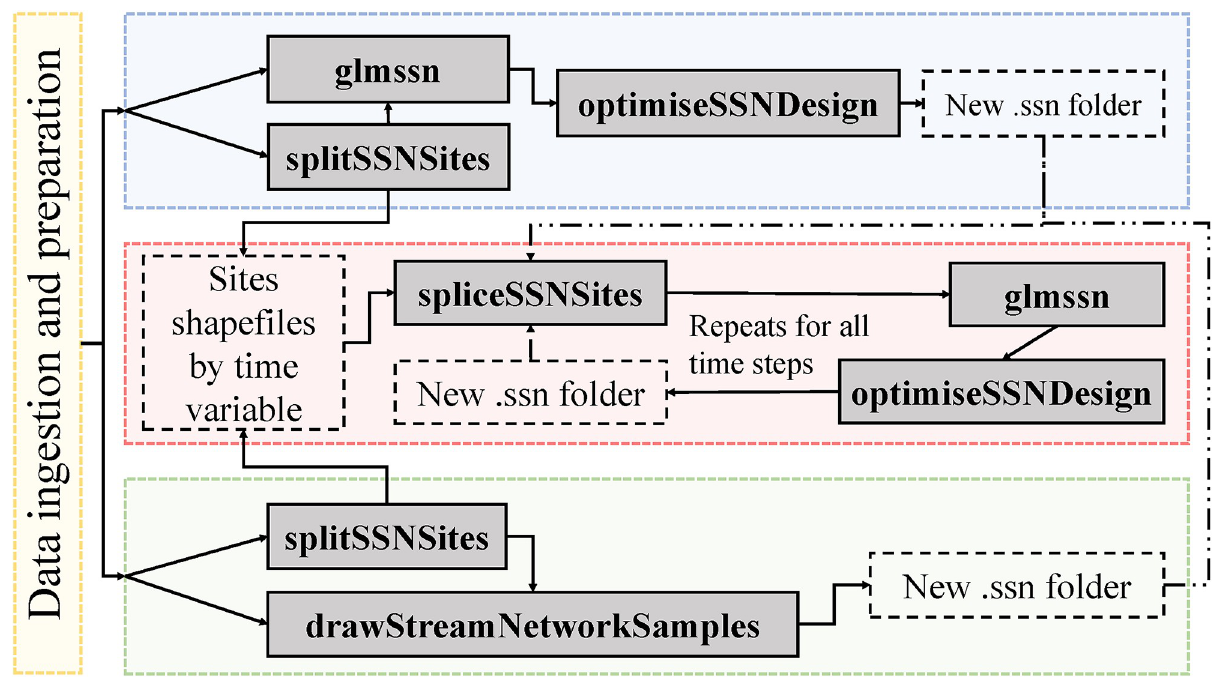
Fig 2. A flow chart of the function calls used to construct optimal (blue), adaptive (red), and probability-based (green) designs for stream networks. The yellow box is discussed in more detail in Fig 1. Grey boxes with solid outlines represent a call to a function (N.B. glmssn belongs to SSN , not SSNdesign ). Clear boxes with dashed outlines indicate a file, folder or R object that is created as a result of a function call. The dash-dot-dot lines represent optional steps or connections between function calls that do not always occur.